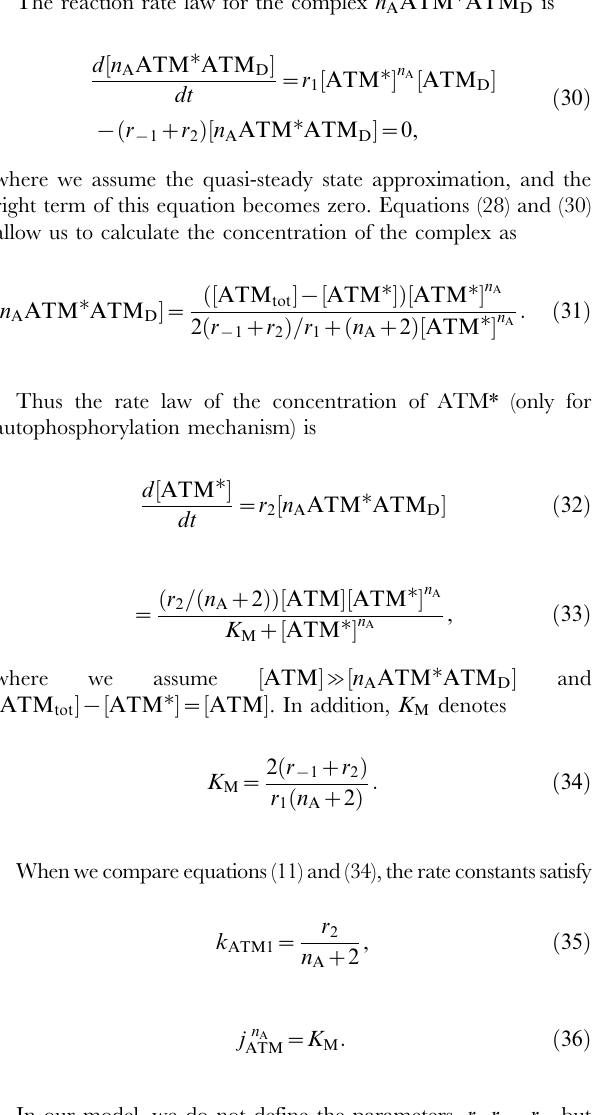
Table 1. The true units of DSBs and DSBCs are not